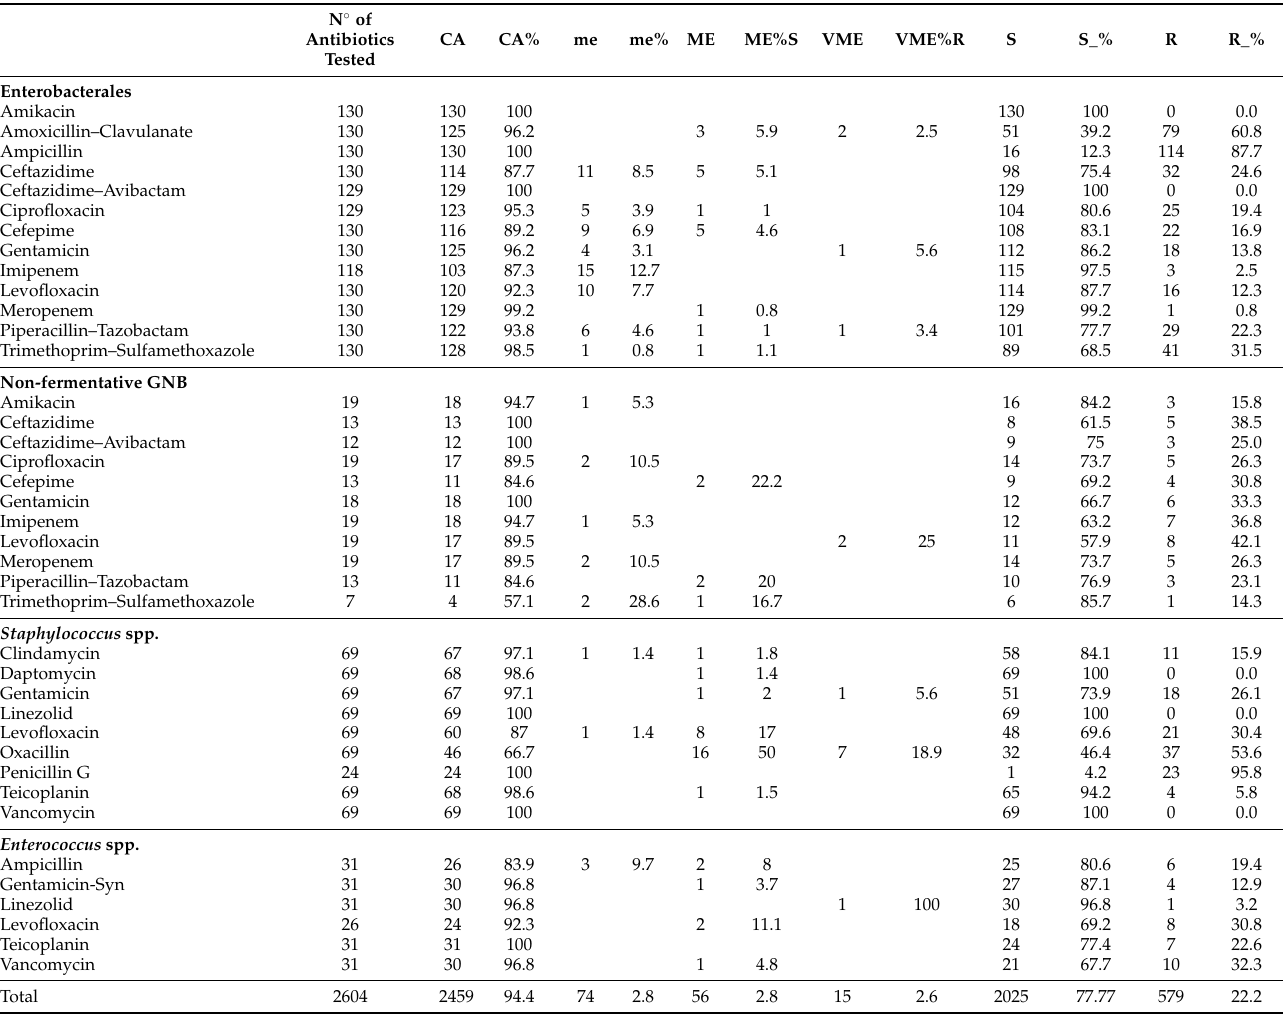
Table 2. Performance characteristics of the QMAC-dRAST by antibiotic and bacterial